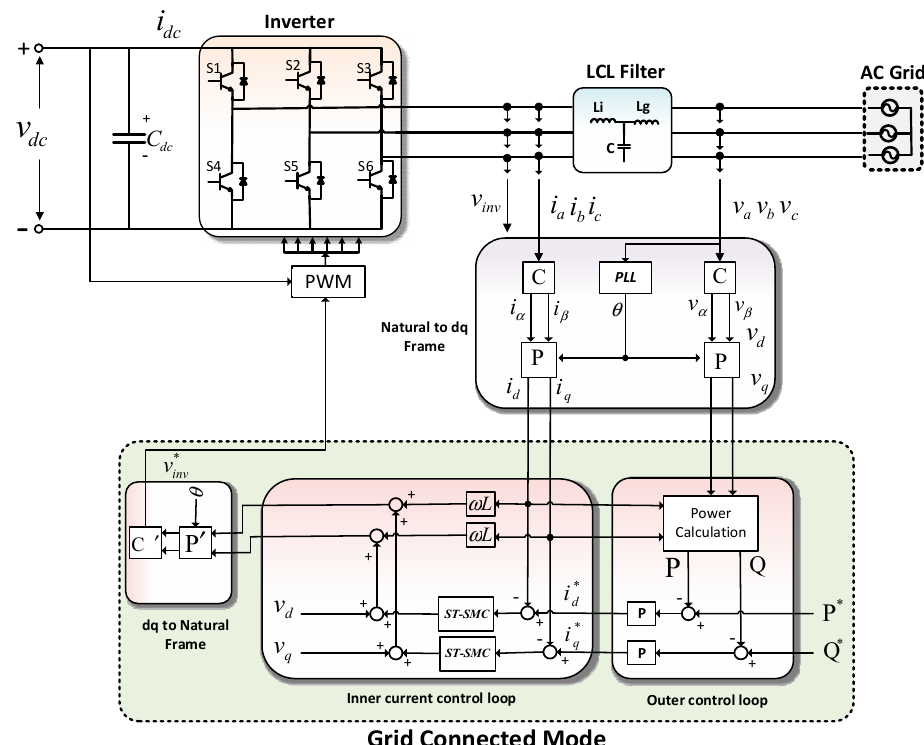
Figure 1. Proposed model for grid-connected and standalone PV system.